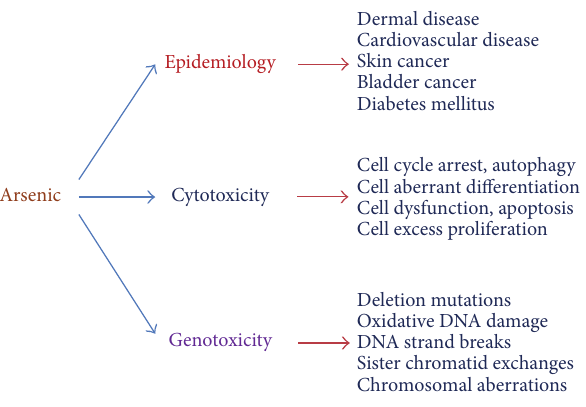
Figure 2: Arsenic toxicity in humans and rats